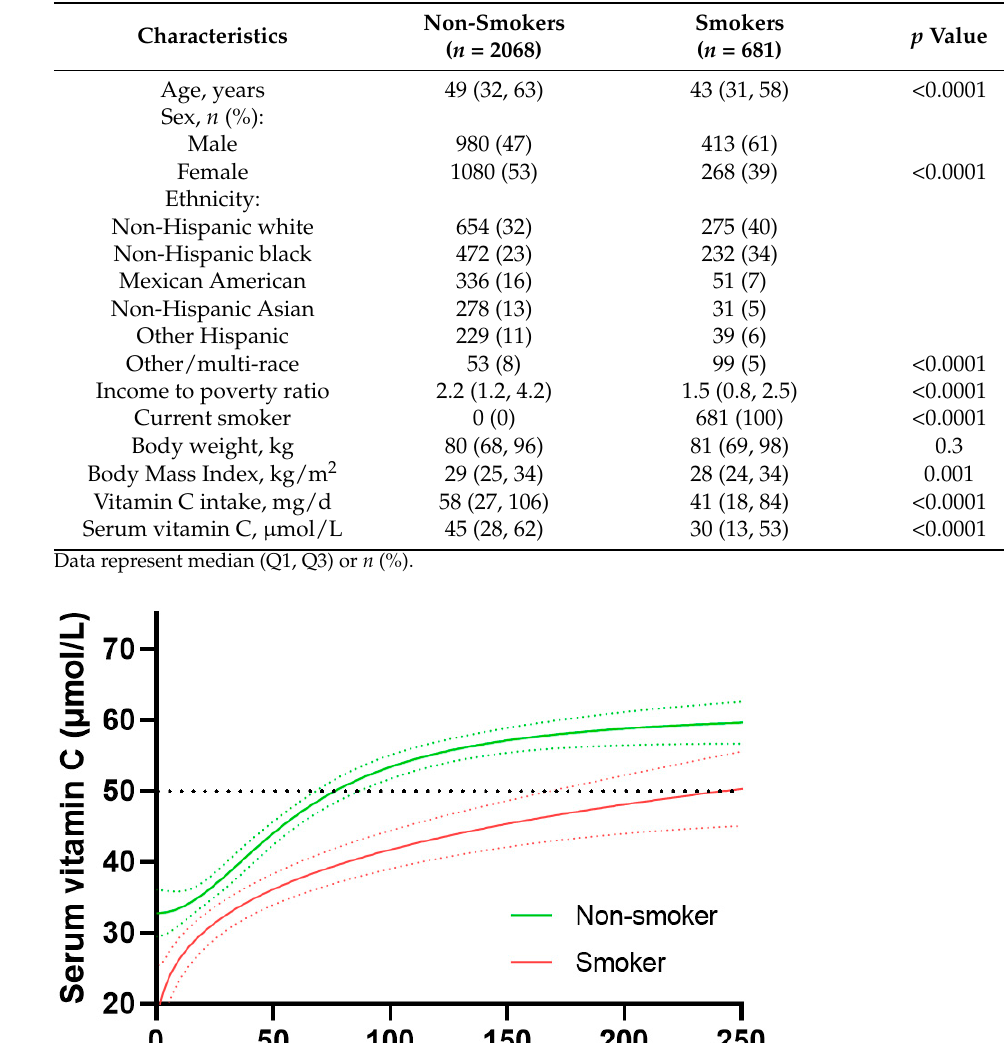
Table 3. Cohort characteristics stratified by smoking status.